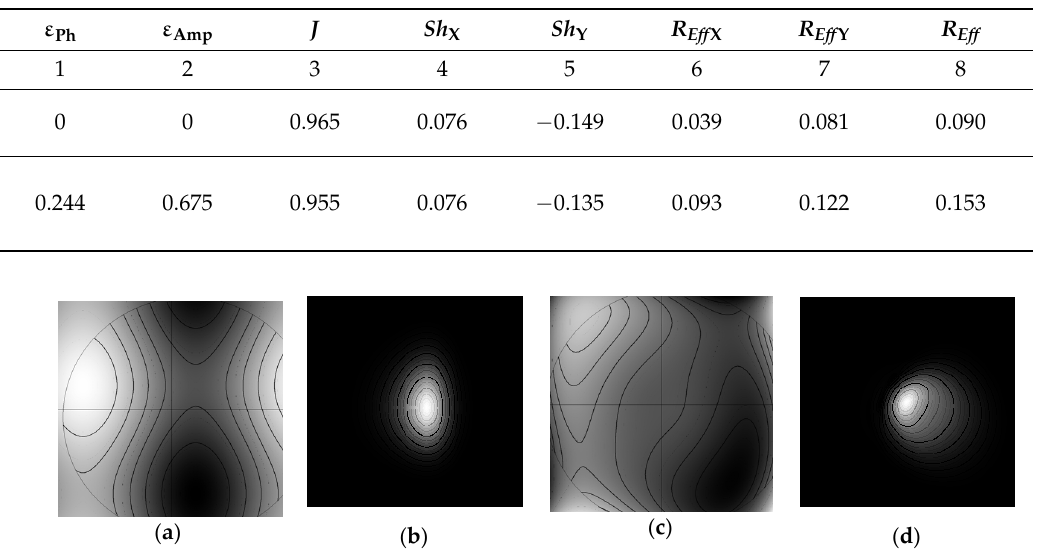
Table 8. Characteristics of the beam in the plane of observations. Parameters of numeric experiment were the same as in the previous example (Figure 16).